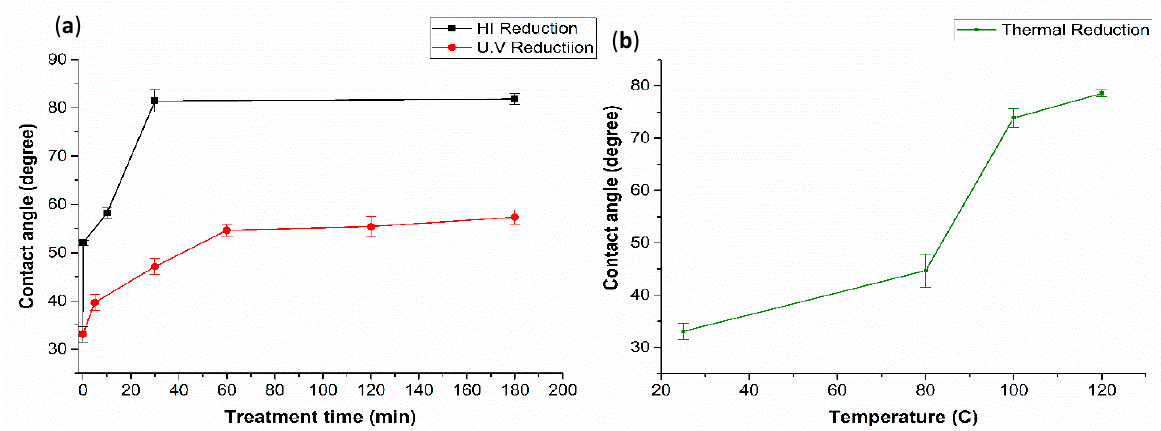
Figure 11. DI water contact angle on the surface of 4 mg/mL GO − coated COC with ( a ) HI and UV reduction time (min) and ( b ) thermal reduction temperature.